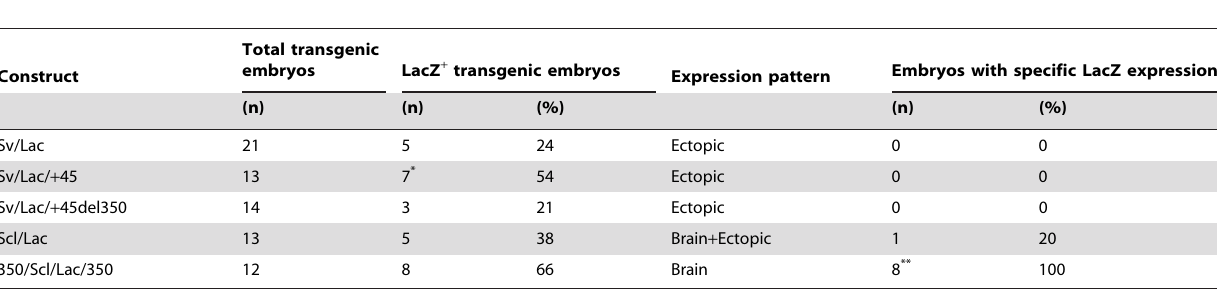
Table 1. The 350 bp core region of the + 45 element insulates transgenic constructs and improves tissue-specific expression from the Scl